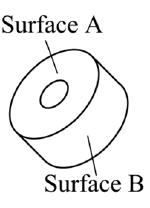
Figure 10. Neodymium magnet. Table 2. Magnetic force to steel surface.